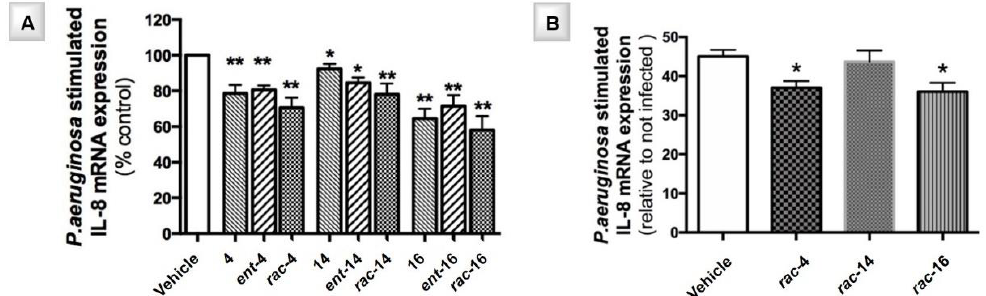
Figure 23. ( A ) Effect of sugar chirality of iminosugars 4,14,16 and ent -( 4,14,16 ) on the inflammatory response to P. aeruginosa in CF bronchial epithelial cells. CuFi-1 cells were treated with the compounds (0.1 μM) for 1 h before P. aeruginosa infection. ( B ) Effect of racemic mixtures on the inflammatory response to P. aeruginosa in CF primary cells. CF bronchial primary cells were treated with the racemic mixtures (0.01 μM) for 1 h before P. aeruginosa infection. * p < 0.05; ** p < 0.01. This figure was reprinted from [179], with permission of Elsevier.